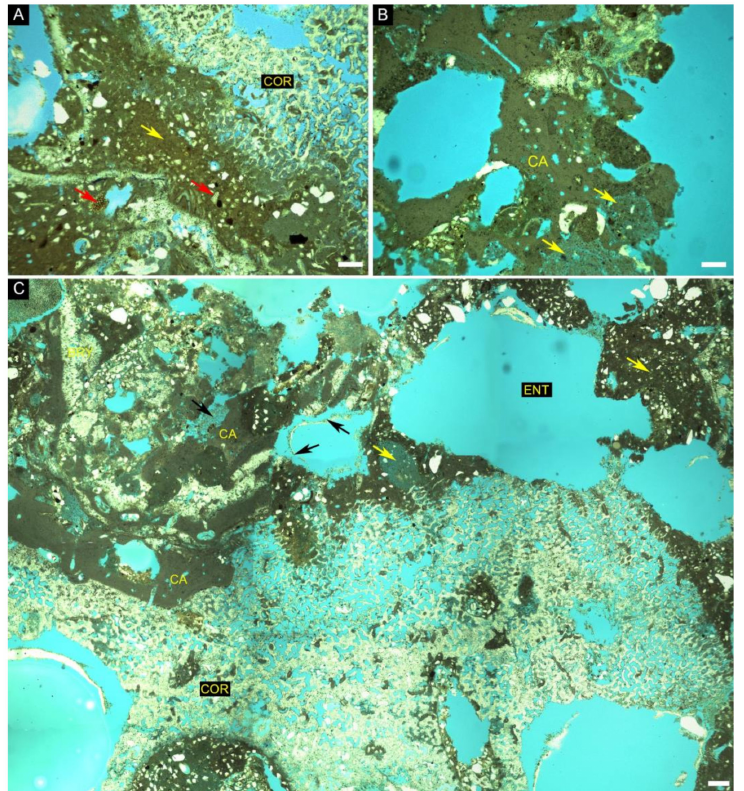
Figure 9. Thin-section images of rhodolith sample 4 from site 3 of the central sector of the SEAL Basin (27 m depth). ( A ) Middle portion of a rhodolith with coral (COR) with borings partially filled by packstone (yellow arrow) and siliciclastic grains, mainly quartz (white color) and bioclasts of echinoids (red arrow); ( B ) Outermost portion of a rhodolith with coralline algae (CA) with some voids filled by wackestone (yellow arrow); ( C ) Rhodolith with coral (COR) nucleus overgrown by coralline algae (CA), with boring and intraskeletal voids partially filled by wackestone (yellow arrow), siliciclastic grains (white) and sponge spicules (black arrows). Borings are attributed to Entobia borings (ENT). Scale bars = 200 µ